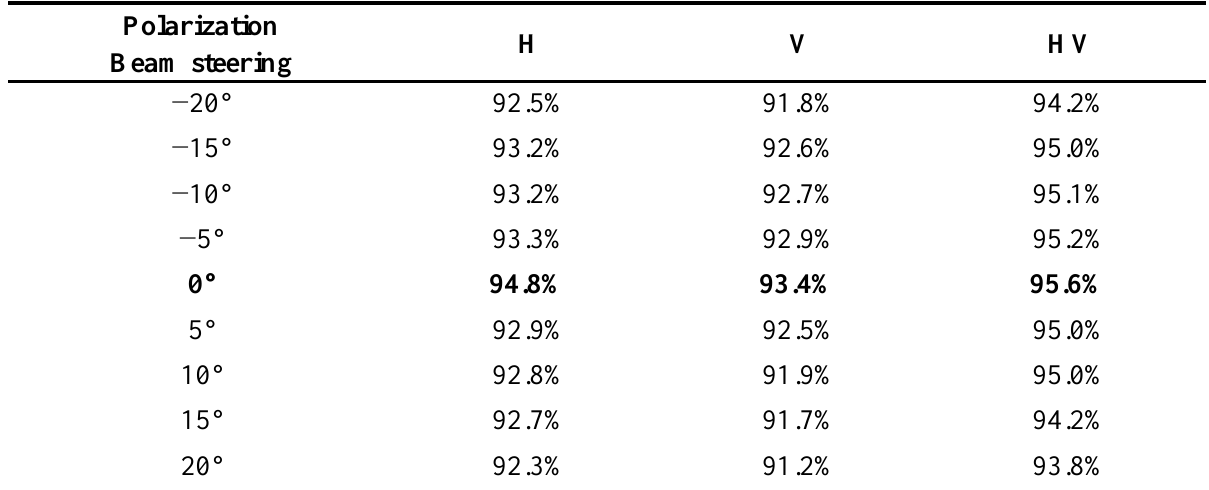
Table 1. MBE for the synthesized beams.